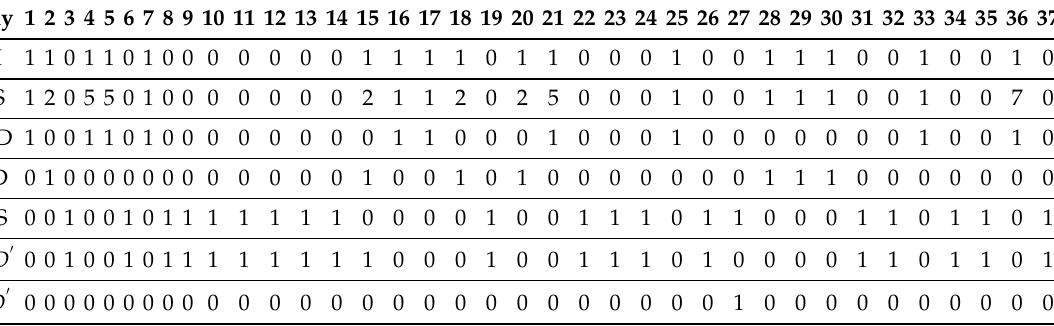
Table 8. The results of ASPF in group